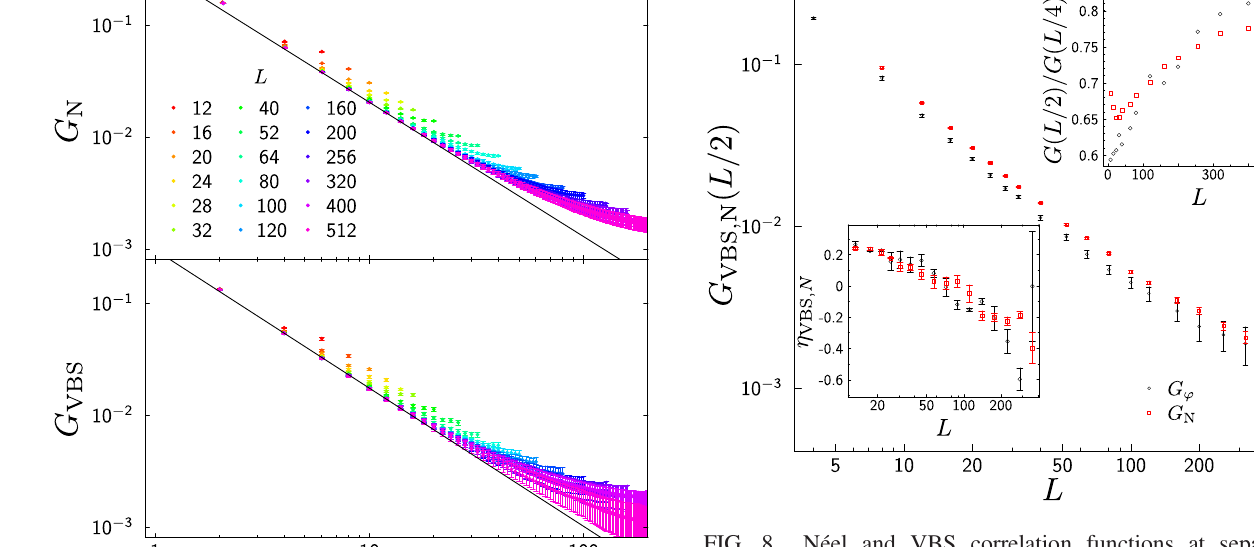
FIG. 8. Néel and VBS correlation functions at separation r ¼ L= 2 , plotted against L on a log-log scale. The slopes give effective finite-size exponent values η plotted in the left inset. The right inset shows the ratio r; L Þ (top panel) and G r; L Þ FIG. 7. Correlators G N é el ð VBS ð G ð L= 2 Þ =G ð L= 4 Þ versus L (bottom panel) plotted against r , for various L . Straight lines 0 . 259 ð 6 Þ and η 0 . 25 ð 3 Þ correspond to the estimates η N é el ¼ VBS ¼ from Eq. (12). G ð L= 2 ; L Þ as a function of L . According to Eq. (10), VBS these scale as L − ð 1 þ η N é el Þ and L − ð 1 þ η VBS Þ , respectively. In Fig. 8 (main panel), we plot these correlators against L on a log-log scale. The gradual change of slope as a function of L indicates a drift in the effective values of η and η . N é el VBS